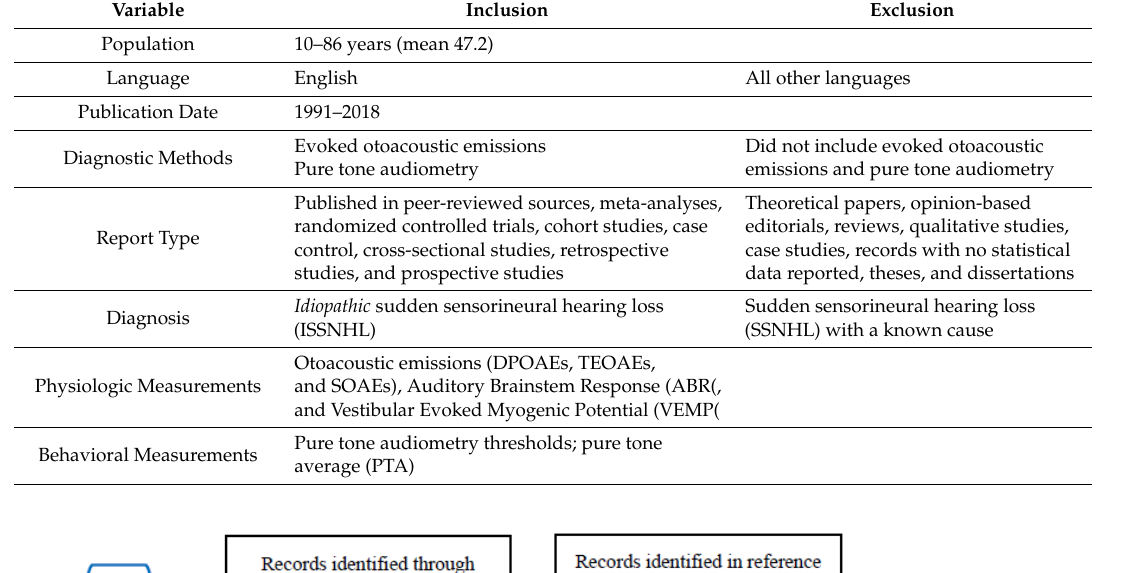
Table 1. Study inclusion and exclusion criteria. DPOAE, distortion product otoacoustic emissions; TEOAE, transient evoked otoacoustic emission.